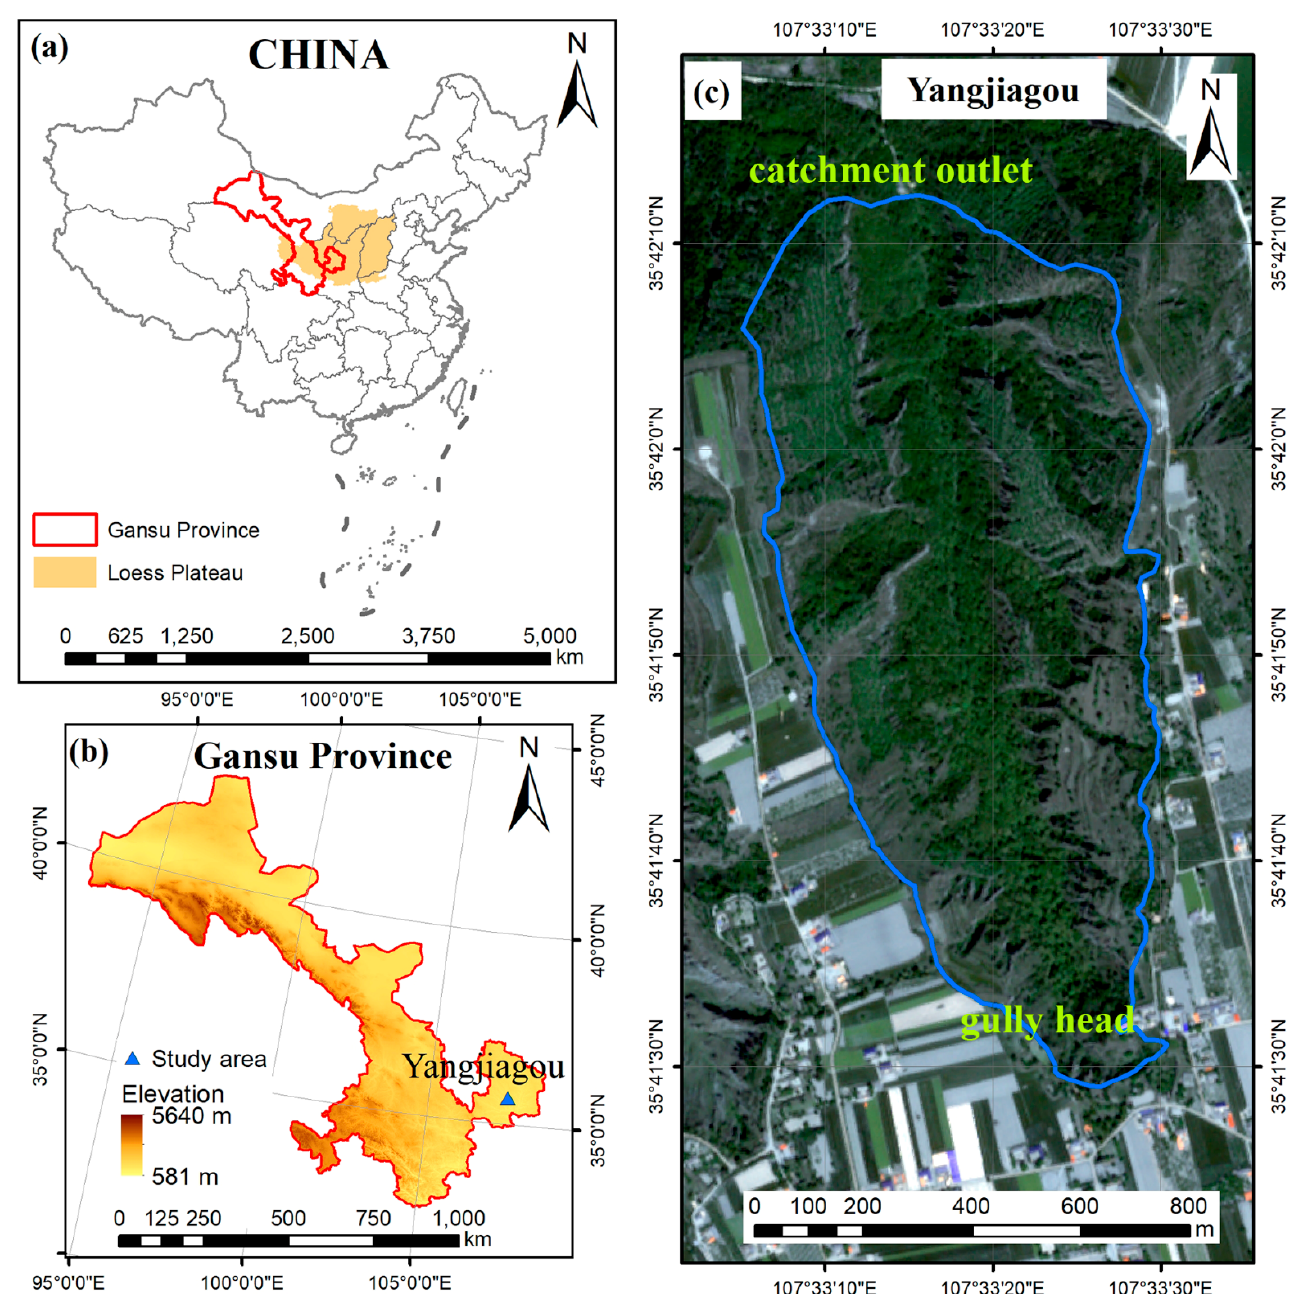
Figure 1. Geographical location of the study area. ( a ) China; ( b ) Gansu province; ( c ) Yangjiagou headwater catchment.